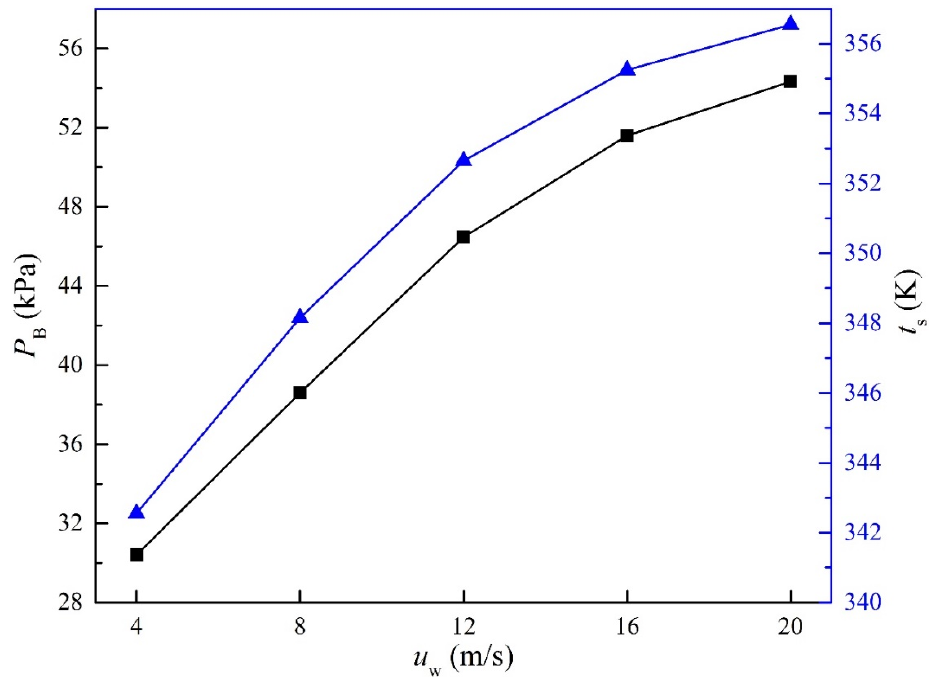
Figure 7. Variations of turbine back pressure and exhaust steam temperature with wind